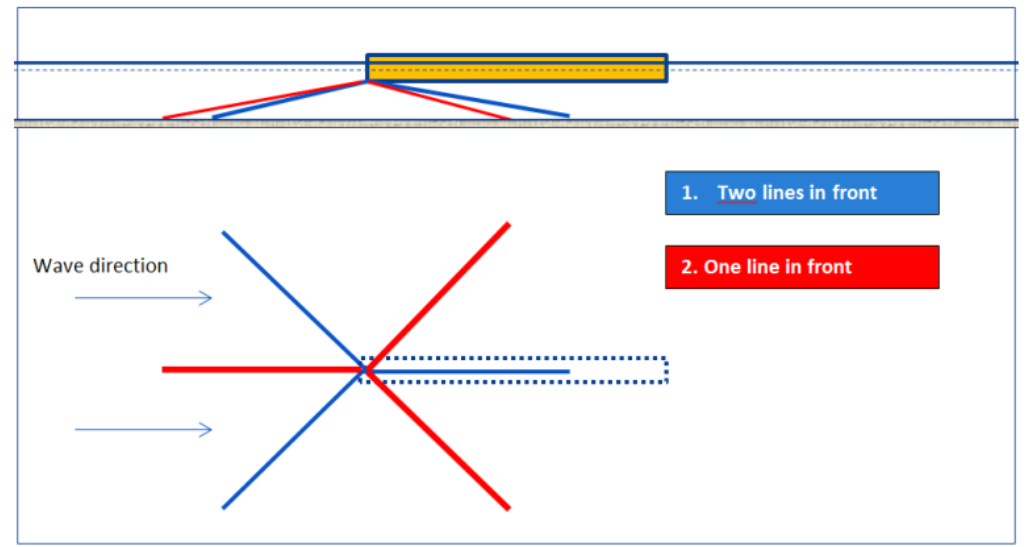
Figure 7. Illustration of the mooring model.